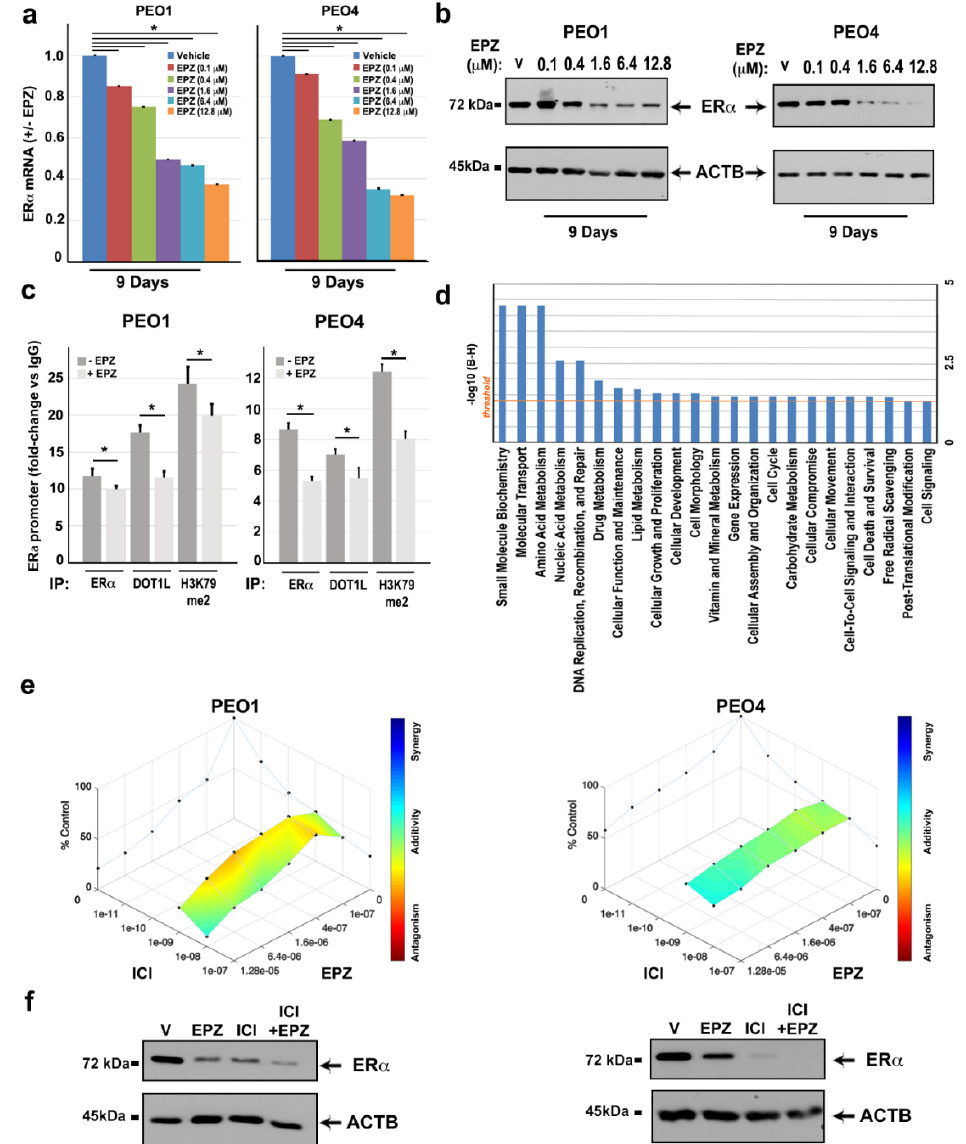
Figure 5. E ff ects of EPZ on ER α -DOT1L co-localization and transcriptional regulation of target genes with ERE motifs and anti-proliferative activity in combination with anti-estrogen compounds. RT-qPCR ( a ) and immunoblotting ( b ) analysis show the e ff ects of EPZ, with respect to Vehicle (V, DMSO), on ER α mRNA and protein. Error bars represent the mean of triplicate values ± SD (* p ≤ 0.05). ( c ) ChIP–qPCR analysis of ER α , DOT1L, and H3K79me2 localization in the ER α promoter region before and after nine days of treatment with EPZ (6.4 µ M). Data are relative to triplicate measurements, ± SD (* p ≤ 0.05). ( d ) IPA Pathway analysis on ERE motif-containing genes downregulated by ICI and EPZ in both PEO1 and PEO4 cells. The straight orange line marks the Benjamini Hochberg p -value (B-H) threshold (0.05). ( e ) D-R Lowe graph showing the e ff ects of drug combination between two fixed doses of ICI (1 and 10 nM) and increasing EPZ concentrations after nine days of treatment. ( f ) Western blot analysis of ER α protein levels after treatment with ICI (10 nM) and EPZ (6.4 µ M) alone or in combination. Vehicle (V, DMSO) was used as a control.